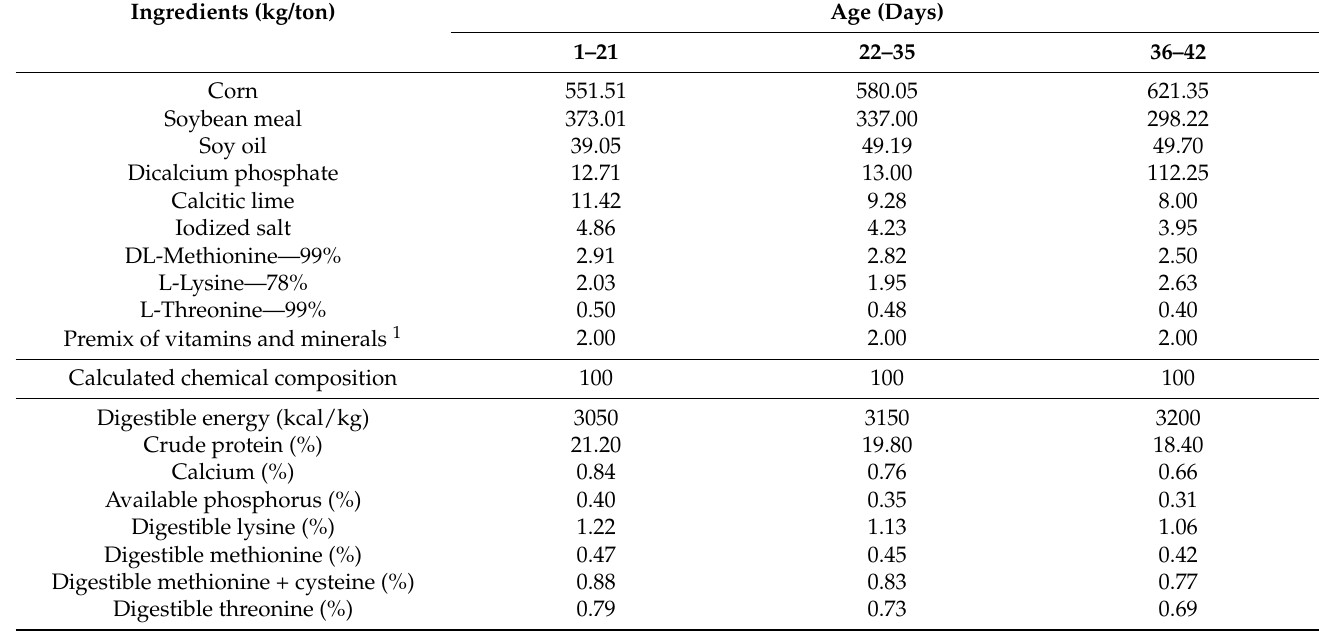
Table 1. Ingredients in the basal diet used for all experimental groups.